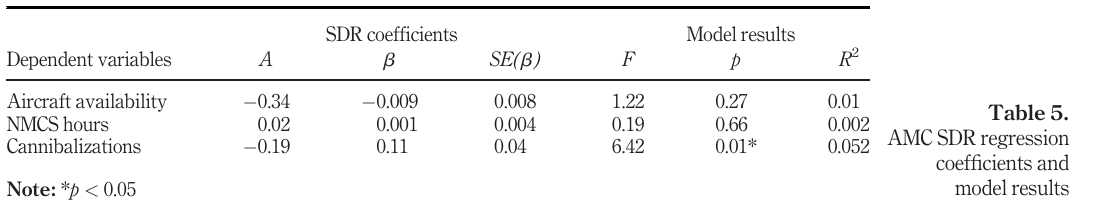
Figure 9. AMC Cann residual plot